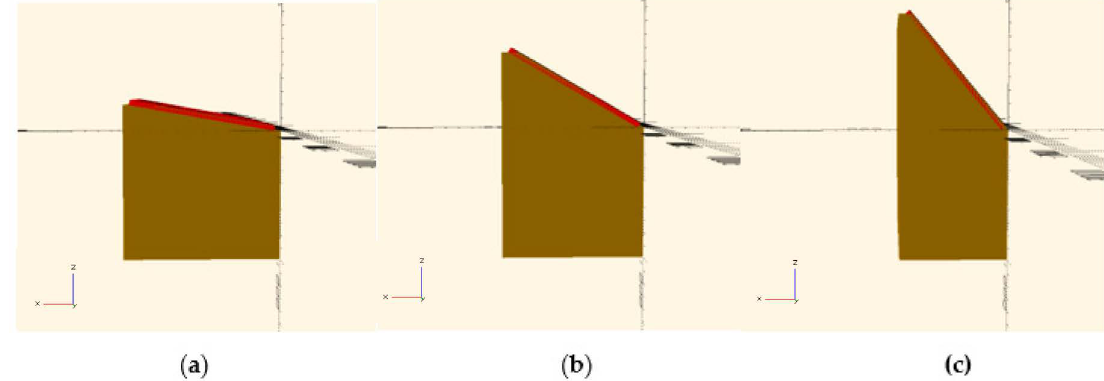
Figure 4. The impact of varying the tilt angle on POSCAS geometry: ( a ) 10, ( b ) 30 and ( c ) 50 degrees. The POSCAS default design does not have a bottom, and can be placed directly on the soil for plant growth (Figure 5a). This minimizes plastic use for fabrication. In the case where the POSCAS array may be set up in areas with no or poor soil (e.g., a parking lot) the POSCAS design can also be adjusted to have a bottom, and thus be used more like a planter (Figure 5b).